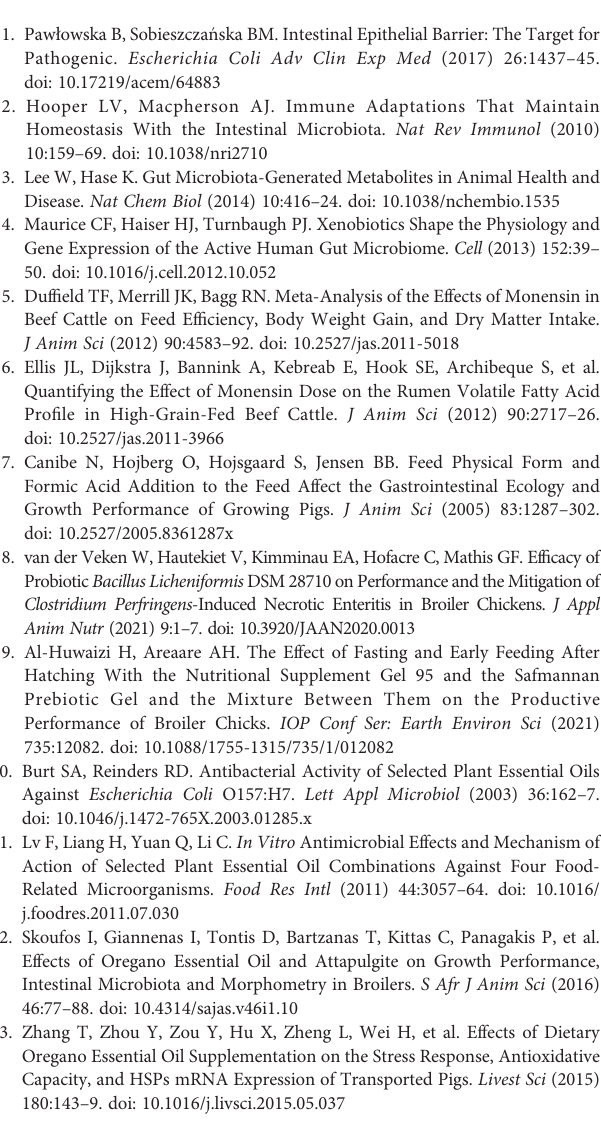
plot showing the bacteria at the genus level that had signi fi cant differences between the CON and trial groups. Positive differences indicate greater abundance of bacteria in the CON group, while negative differences indicate greater abundance in the trial group. Supplementary Figure 2 | (A, B) OPLS-DA score plots showed signi fi cantly separated clusters between trial and CON group (CON vs MON, CON vs LR). (C) Box-plot of each signi fi cantly different metabolite peak area (Log10 transformed) among treatments. Data was presented as median and whiskers represented the Tukey. (D, E) Bar-chart showing the fold change of top 20 different metabolites (CON vs MON, CON vs LR). (F, G) The KEGG functional enrichment analysis of differential metabolites (CON vs MON, CON vs LR). (H, I) correlation analysis of microbiota and metabolites in the ileal contents (CON vs MON, CON vs LR). Red represents a signi fi cant positive correlation ( P < 0.05), while blue represents signi fi cantly negative correlation ( P < 0.05). Asterisks indicate signi fi cant difference between the trial and CON group (*0.01 < P ≤ 0.05; **0.001 < P ≤ 0.01; *** P ≤